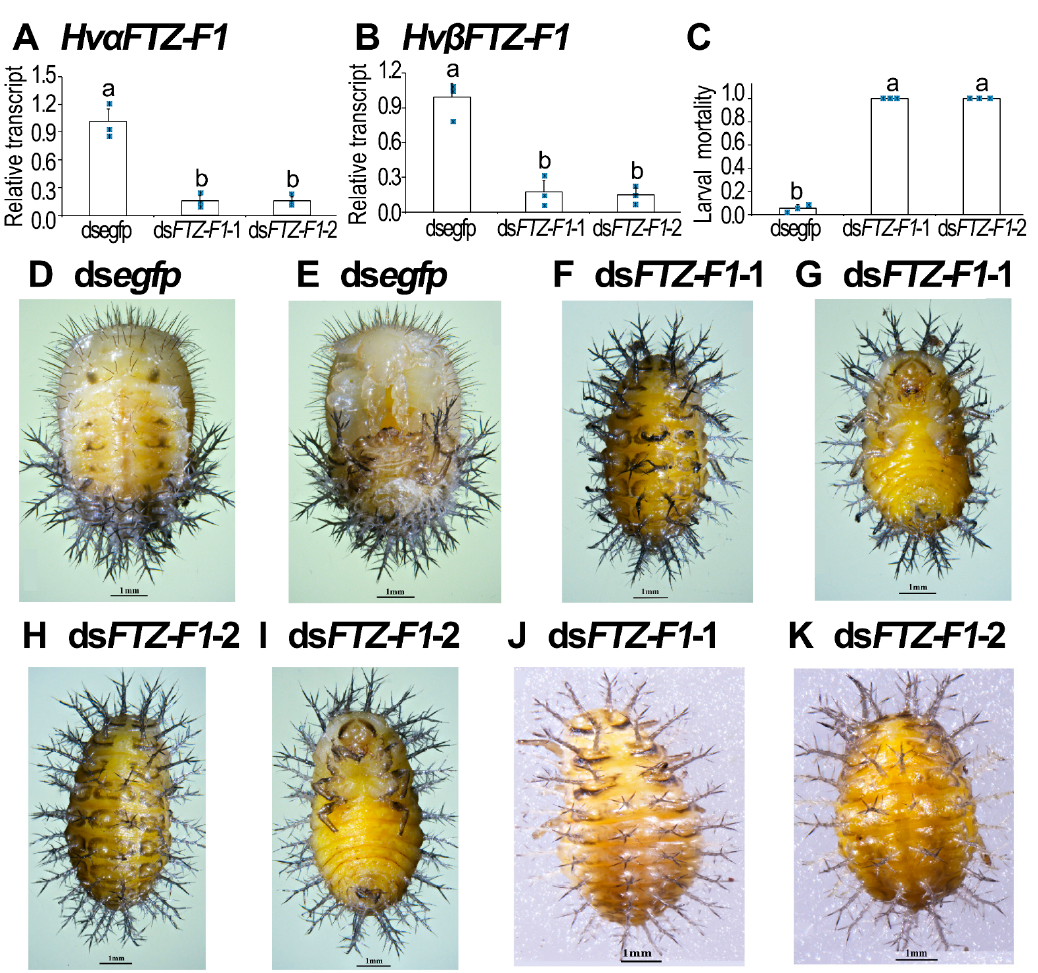
Figure 4. RNAi of both HvFTZ-1 isoforms in final-instar larvae severely impaired larval–pupal transition in Henosepilachna vigintioctopunctata . The newly ecdysed final-instar larvae were injected with an aliquot (0.1 μ L) of solution including 500 ng ds FTZ-F1 -1 or ds FTZ-F1 -2; both dsRNAs were derived from the common sequences of both isoforms. The same amount of ds egfp was injected as negative control group. The larvae were then transferred to potato foliage. Three days after injection, the expression levels of Hv α FTZ-F1 ( A ) and Hv β FTZ-F1 ( B ) were determined. Relative transcripts are the ratios of relative copy number in treated individuals to ds egfp- injected controls, which was set as 1. The values represent means ( ± SE). Different letters indicate significant difference at p -value < 0.05 using analysis of variance with the Tukey–Kramer test. The larval mortality was recorded during a 3-week trial period ( C ). Three biological replicates were repeatedly marked with blue dots. The bars represent values ( ± SE). Different letters indicate significant difference at p -value < 0.05. While the ds egfp larvae pupated 6 days after initiation of bioassay ( D , E ), all HvFTZ-F1 RNAi larvae